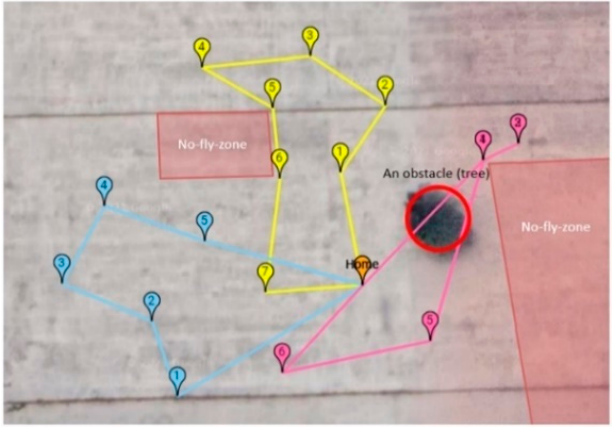
Figure 25. Route following route planning and assignment.